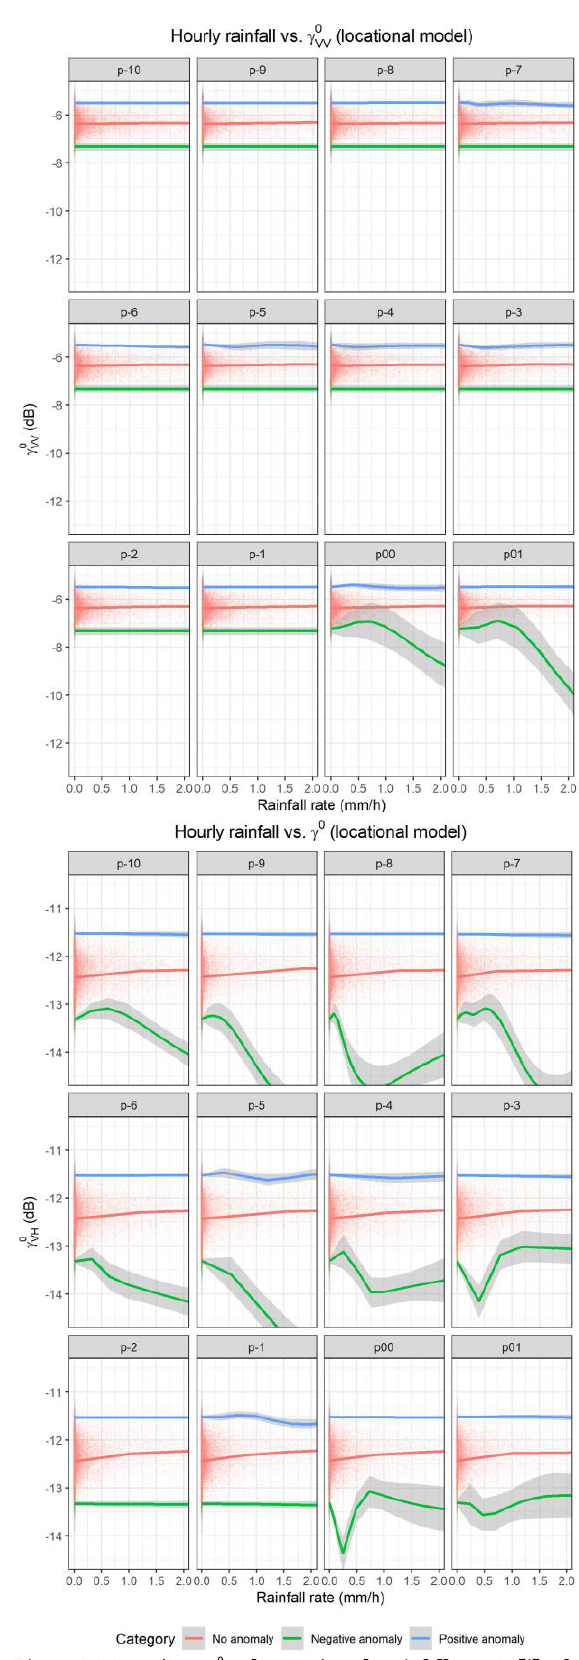
Figure 4: VV and VH γ 0 values vs. hourly rainfall rate. P-[i] refers to the rain rate [i] hours before the acquisition of the SAR data. p01 refers to rain one hour after. Continuous lines are GAM models. Grey shades represent model 95% confidence